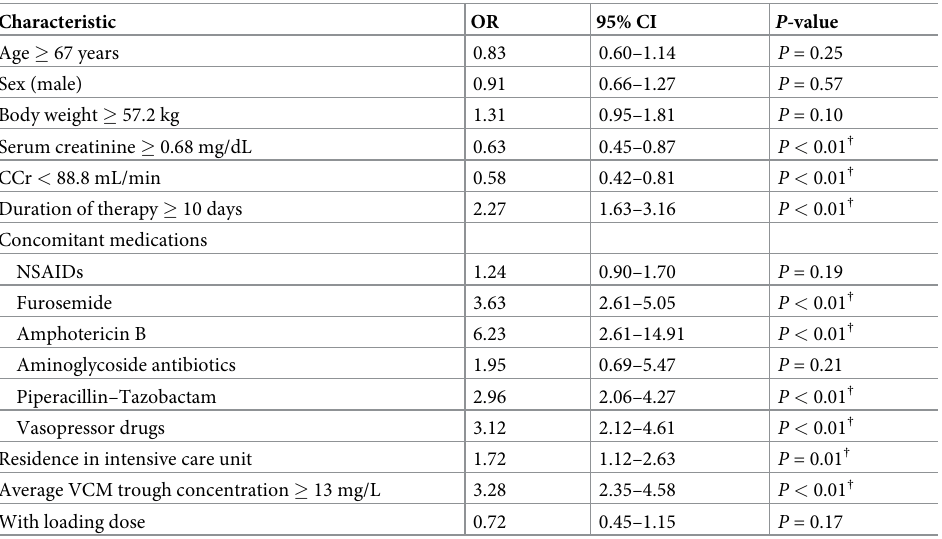
Table 2. Univariate analysis of risk factors for nephrotoxicity.